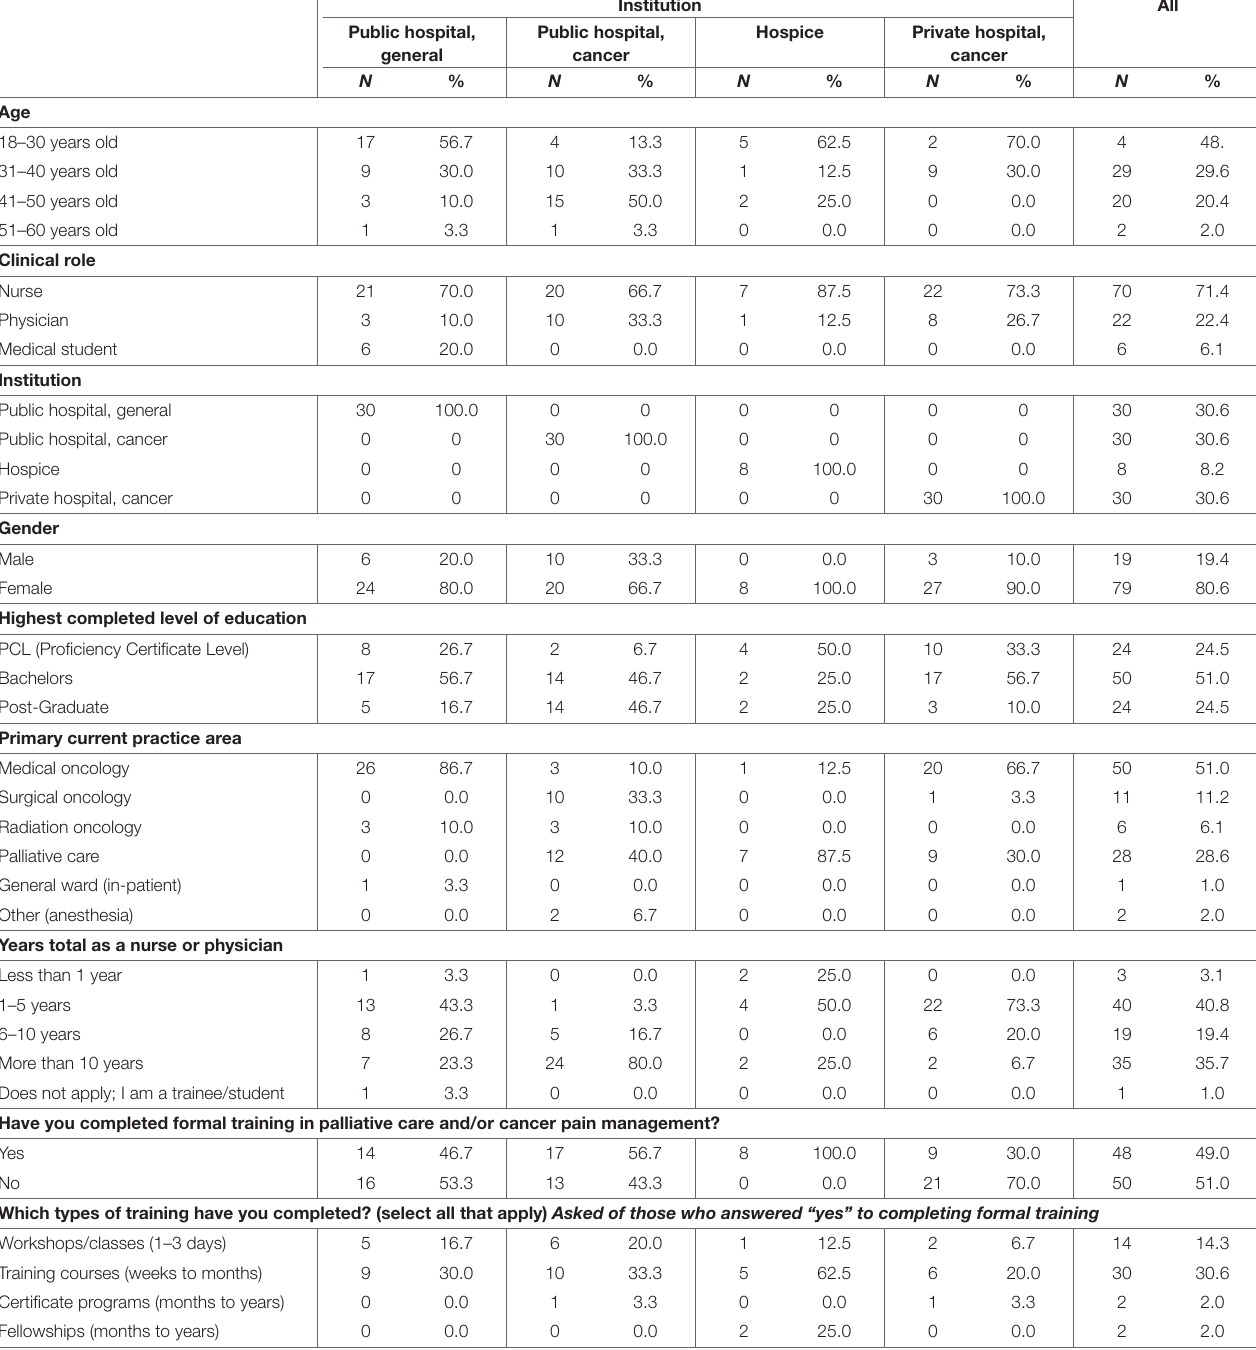
TABLE 4 | Demographics of participants who tested the NAPCare PMG mobile